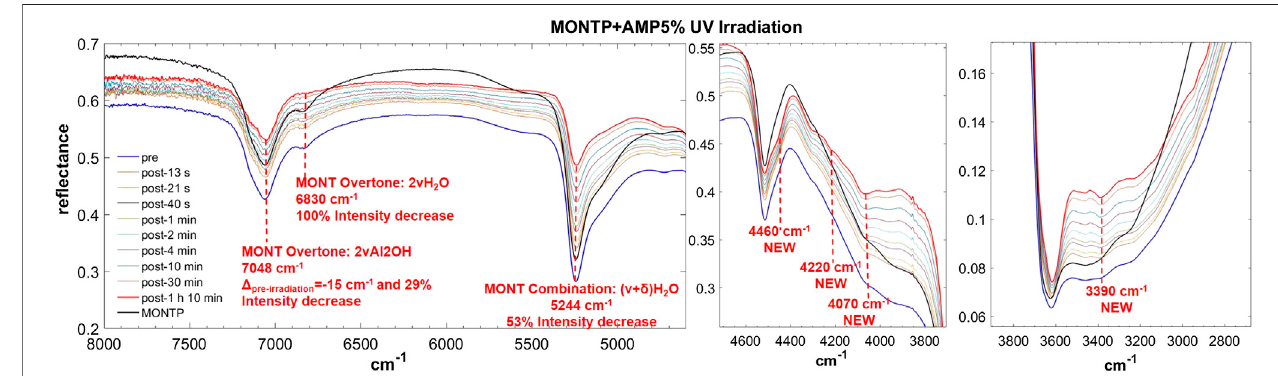
FIGURE 8 | Main changes in NIR features after 70 min of UV irradiation for AMP 5 wt% on montmorillonite containing 1 wt% of Mg-perchlorate. Legend: Δ pre-irr (cid:2) wavenumber shift with respect to the same peak pre-irradiation; ν (cid:2) stretching vibrational mode; δ (cid:2) bending vibrational mode.